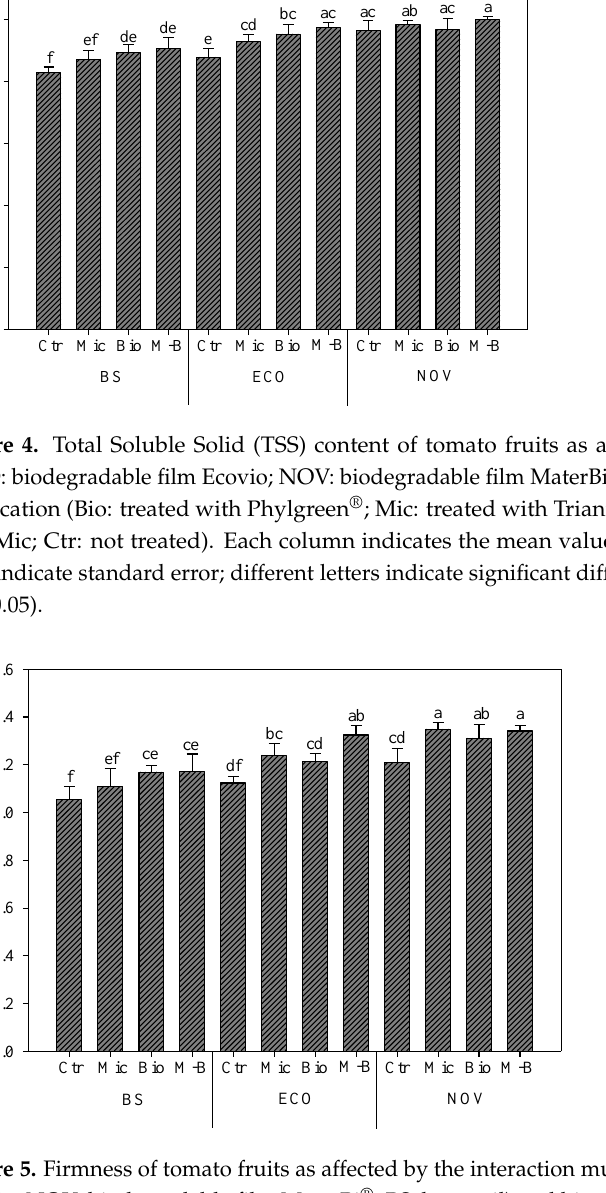
Figure 5. Firmness of tomato fruits as affected by the interaction mulching (ECO: biodegradable film Ecovio; NOV: biodegradable film MaterBi ® ; BS: bare soil) and biostimulant application (Bio: treated with Phylgreen ® ; Mic: treated with Trianum-P ® ; M-B: combination of Bio and Mic; Ctr: not treated). Each column indicates the mean value of the three replicates. Vertical bars indicate standard error; different letters indicate significant differences according to Tukey’s test ( p < 0.05).